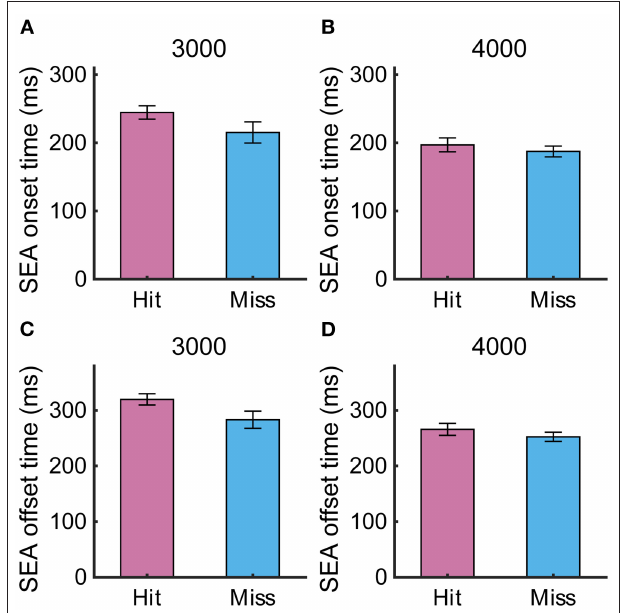
FIGURE 4 | (A,B) SEA onset time and (C,D) offset time at target speeds of 3,000 and 4,000 pixels/s in Experiment 1. Pink and light blue bars show Hit and Miss, respectively. Error bars are